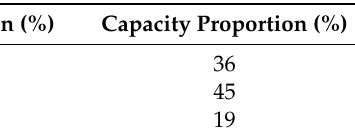
Table 3. China’s closed coal mines in